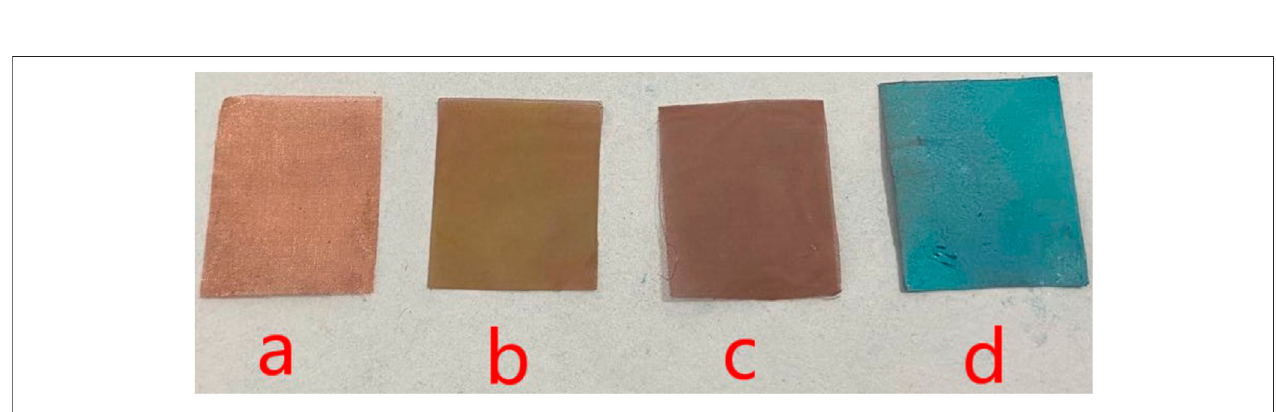
FIGURE 3 | Color change of copper